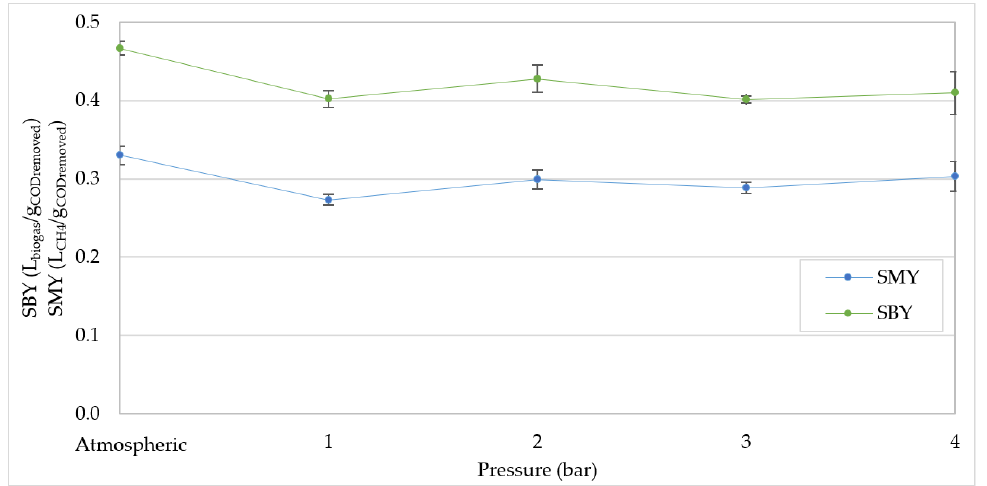
Figure 5. CH 4 and CO 2 percentages at increasing pressures for organic load rate (OLR) of 30 kg COD /m 3 d.